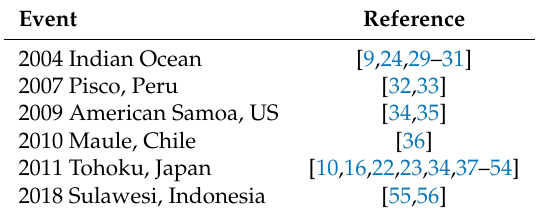
Table 2. A list of tsunami disaster events and the remote sensing-based research related to